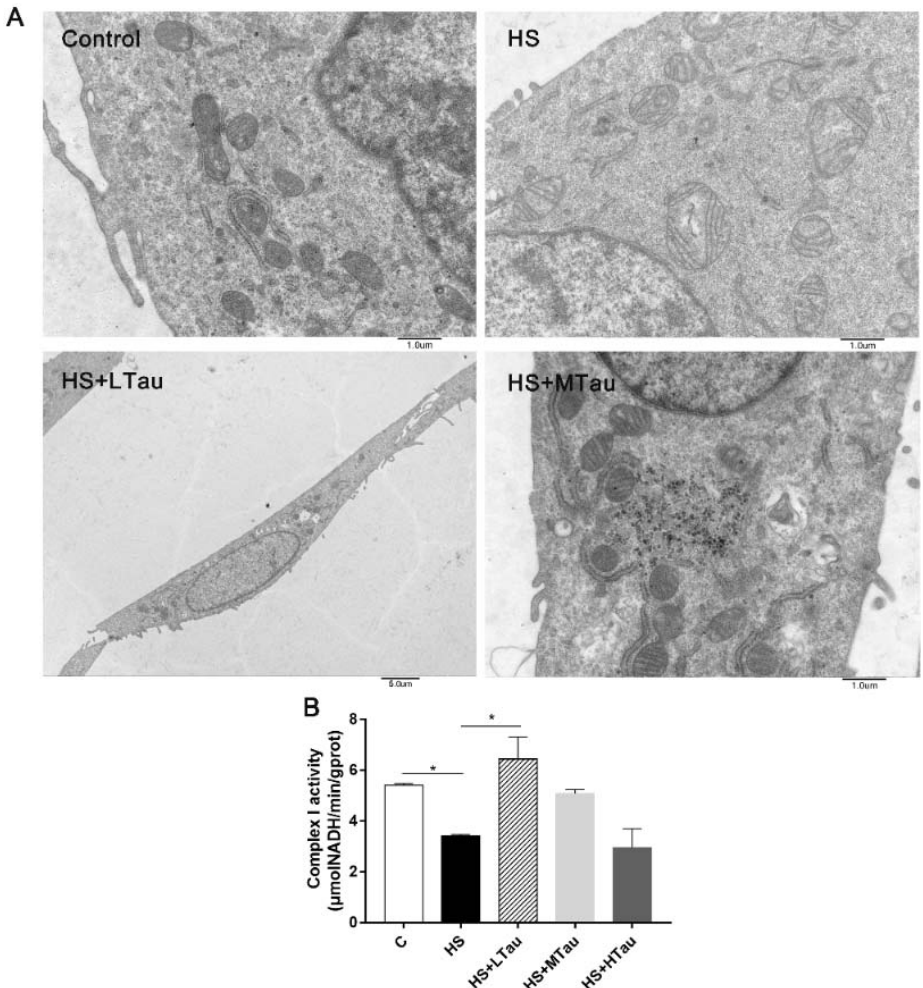
Figure 3. Taurine supplementations relieve the damage done to the mitochondrial structure and the decline in complex I activity in MAC-T cells under heat exposure. ( A ) the mitochondrial structures and ( B ) mitochondrial complex I activity. Transmission electron microscopy images at original magnifications of × 8000 Control, heat stress (HS), and moderate taurine (HS + MTau), and × 2000 low taurine (HS + LTau). * p < 0.05.